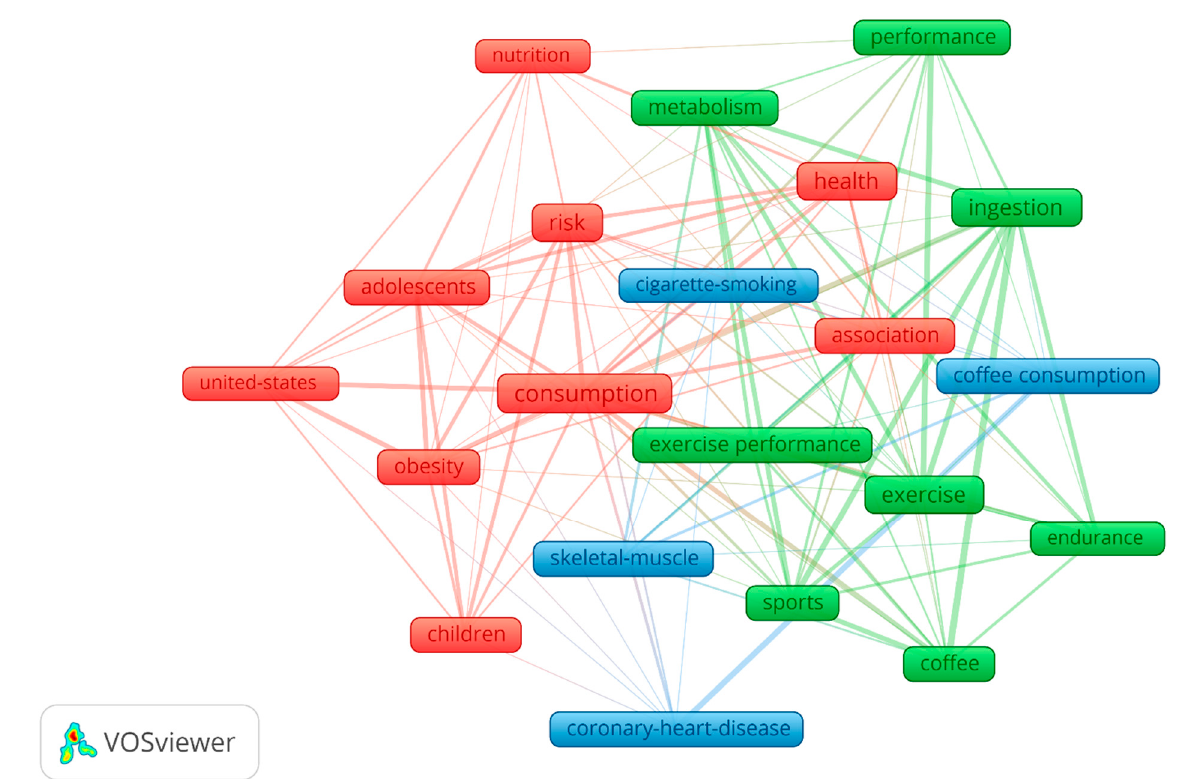
Figure 7. Thematic author keywords graph.